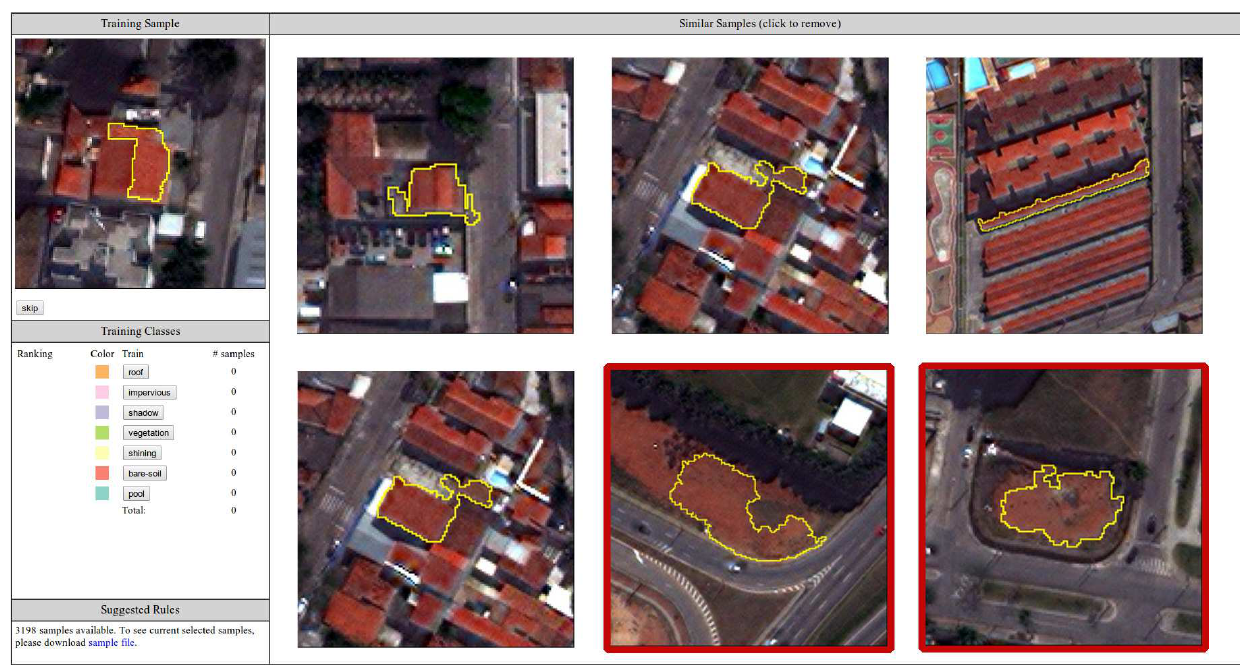
Figure 5. The GUI showing a target segment (on the left, marked as Training Sample ) and candidates to be included in the sample selection. The misclassified candidates are highlighted in red